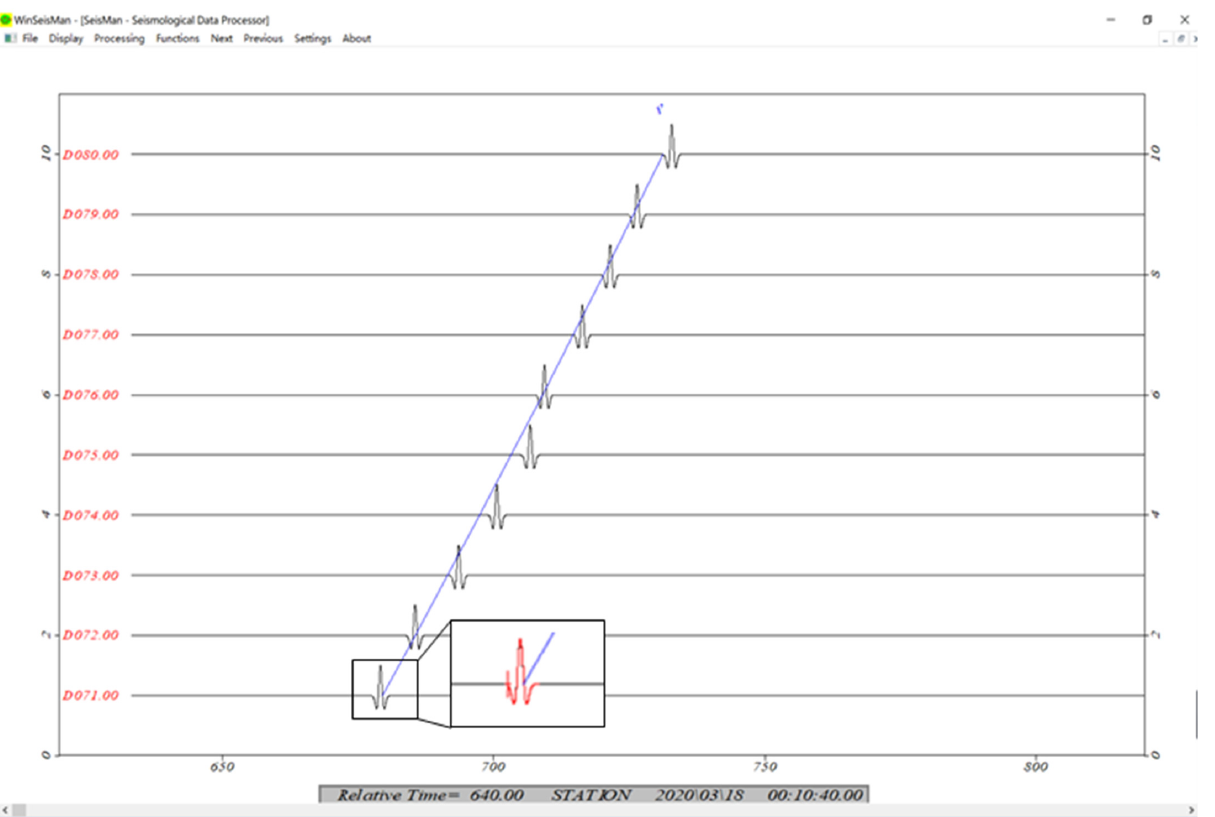
Figure 3. Synthetic seismic waveform recordings with random noise added and theoretical traveltime curves and wavelet selection.